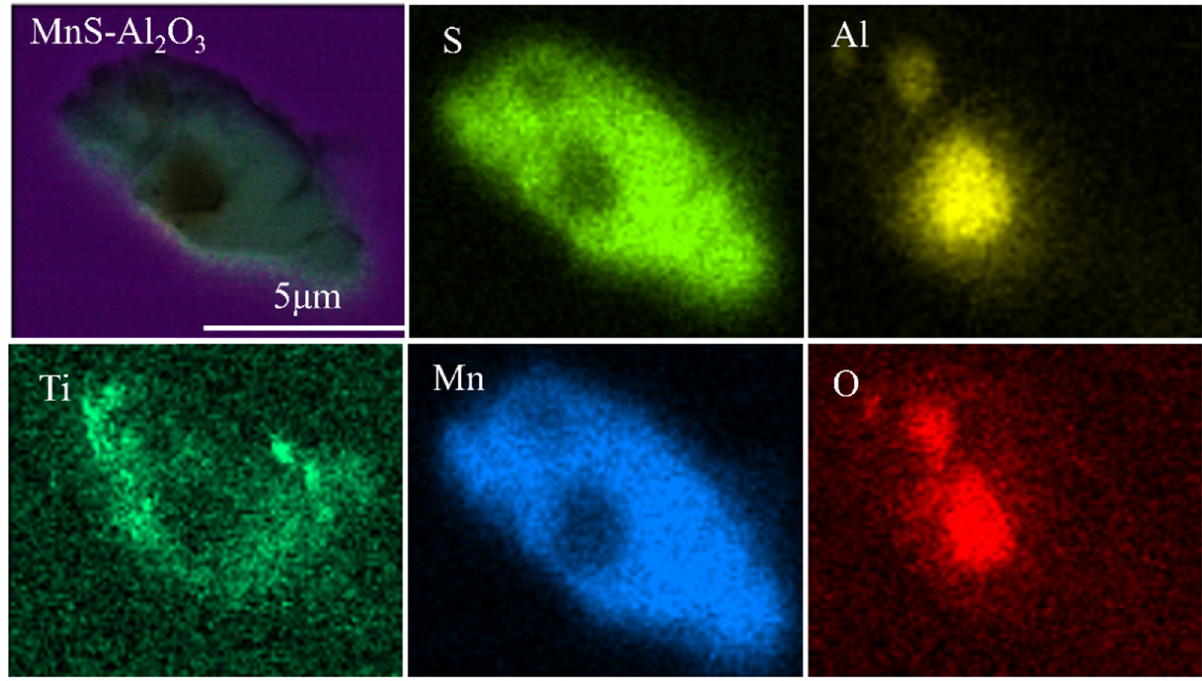
Figure 3: Element distribution of MnS – Al 2 O 3 inclusions in hot - rolled Y - free